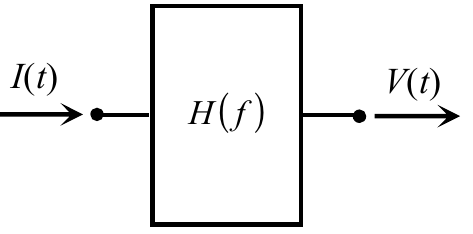
Figure 9. The prediction method of the numerical model.